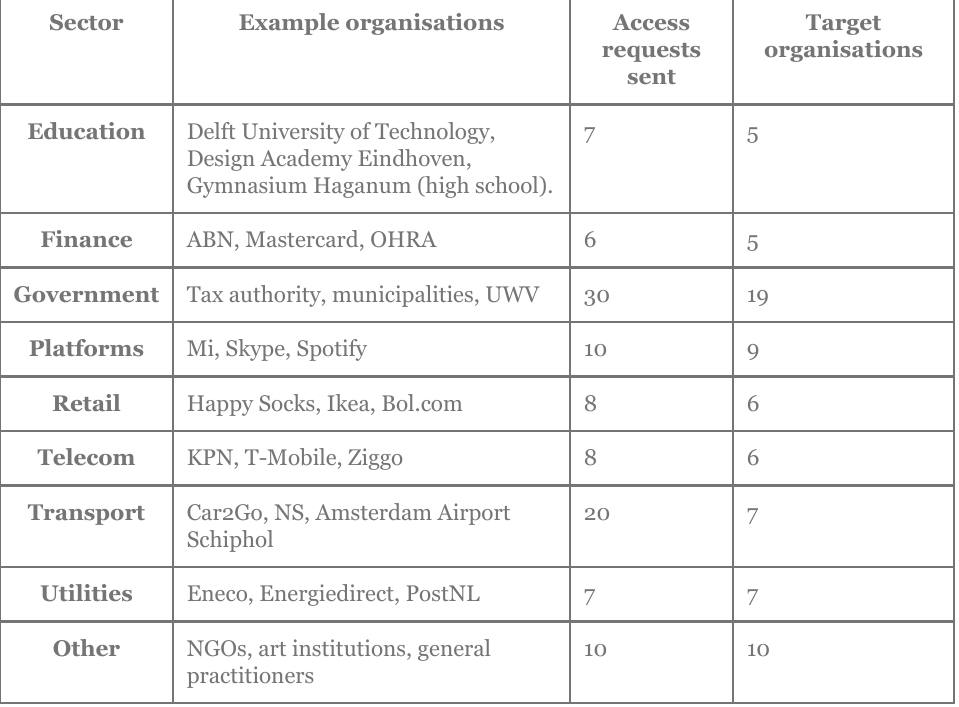
Table 1: Number of data access requests sent to different